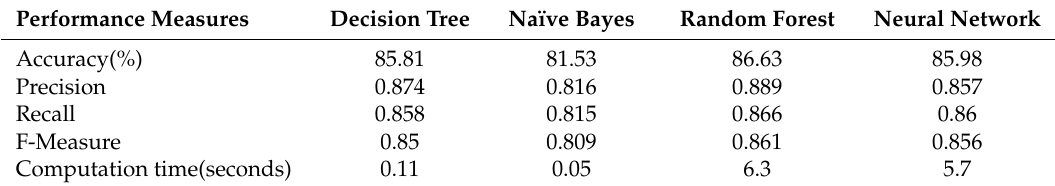
Table 5. Comparison of Classification Algorithms. The measures are averages of 10-fold cross-validation results produced from classifying 52 classes